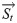
Significance testing of the electrode contributions to the electrical receptive fields (ERFs) and model summary.A) Three stimulus frames (t−2, t−1, and t0) of the true excitatory filter for a cell (black) are compared to a distribution of randomly time-shifted filters (grey). Each stimulus frame contains 20 amplitudes representing the amplitudes of the 20 stimulating electrodes. A 95% confidence limit is calculated from the distribution (dark grey) to which the actual values can be compared. In this example, three electrodes (denoted by stars) from t0 significantly affected the response of the neuron, and none from t−1 or t−2. B) A block diagram illustrating the steps of the GQM procedure. An input stimulus, St→, is linearly filtered and squared (for the case of v→1 to v→N). The outputs are then added or subtracted depending on whether the linear filter is excitatory or suppressive, respectively. An estimate of the response is produced by transforming the result with a sigmoidal nonlinearity.